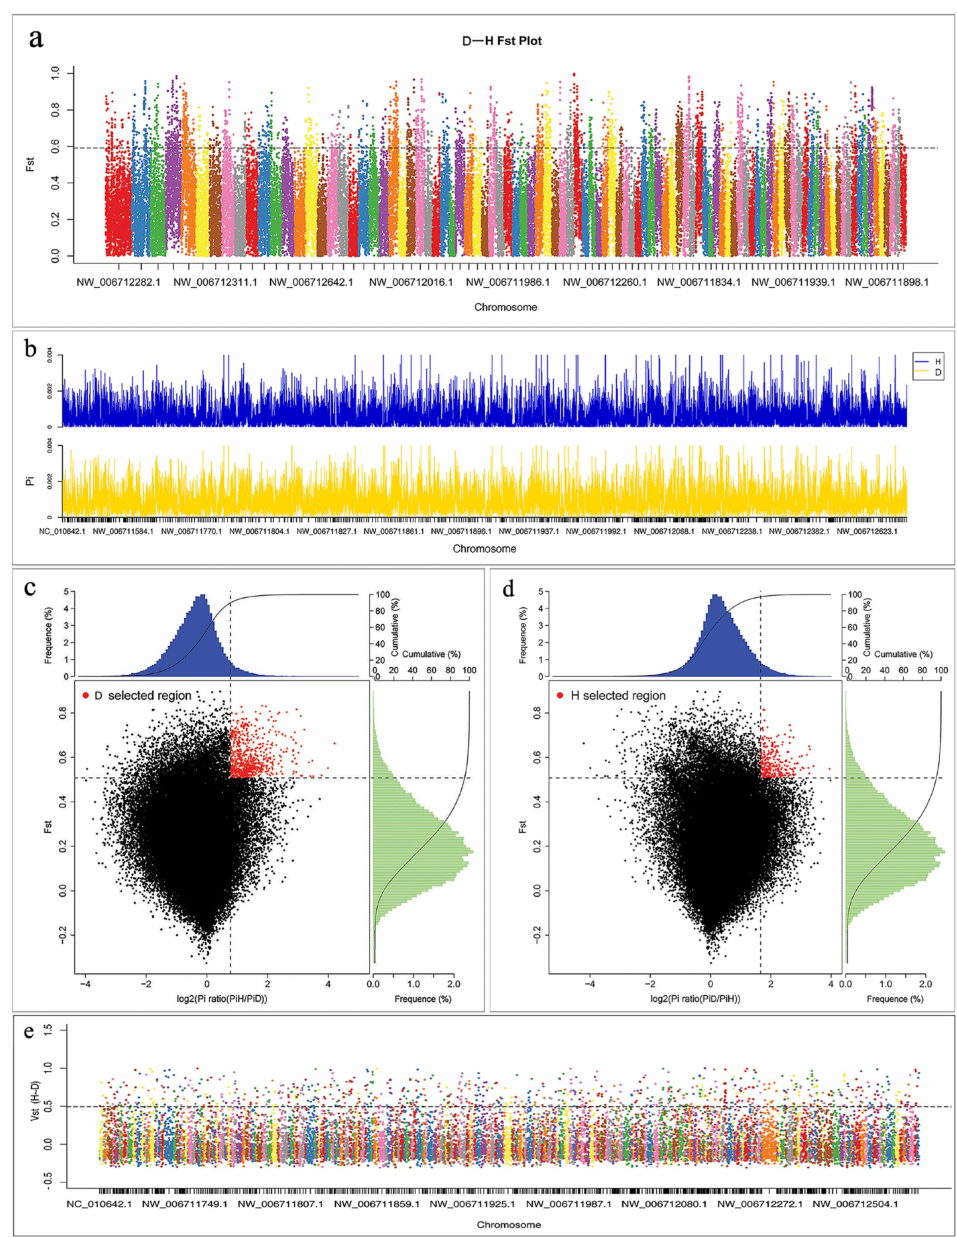
Figure 3. Screening of selective sweeps. ( a ) Genome–wide distribution of F st between the Amur and the South China tiger base on SNP. The horizontal dashed line indicates the threshold defining the selective sweeps (F st ≥ 0.59). ( b ) The θπ distribution. ( c , d ) Identification of genomic regions with strong selective sweep signals in Amur tiger and South China tiger. Data points located to the right of the vertical lines (corresponding to 5% right tail of the empirical log 2 ( θπ ratio) distribution) and above the horizontal line (5% right tail of the empirical F st distribution) where identified as selected regions (red points). ( e ) Selection analyses identified the selection signal based on V st method. A dashed horizontal line indicates the cut − off (V st > 0.439) used for extracting